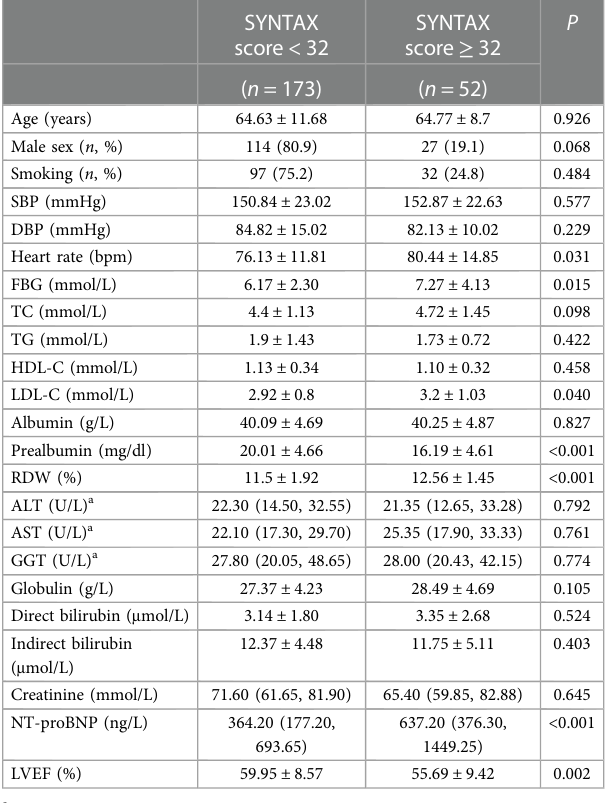
TABLE 3 Comparison of indexes in different SYNTAX score